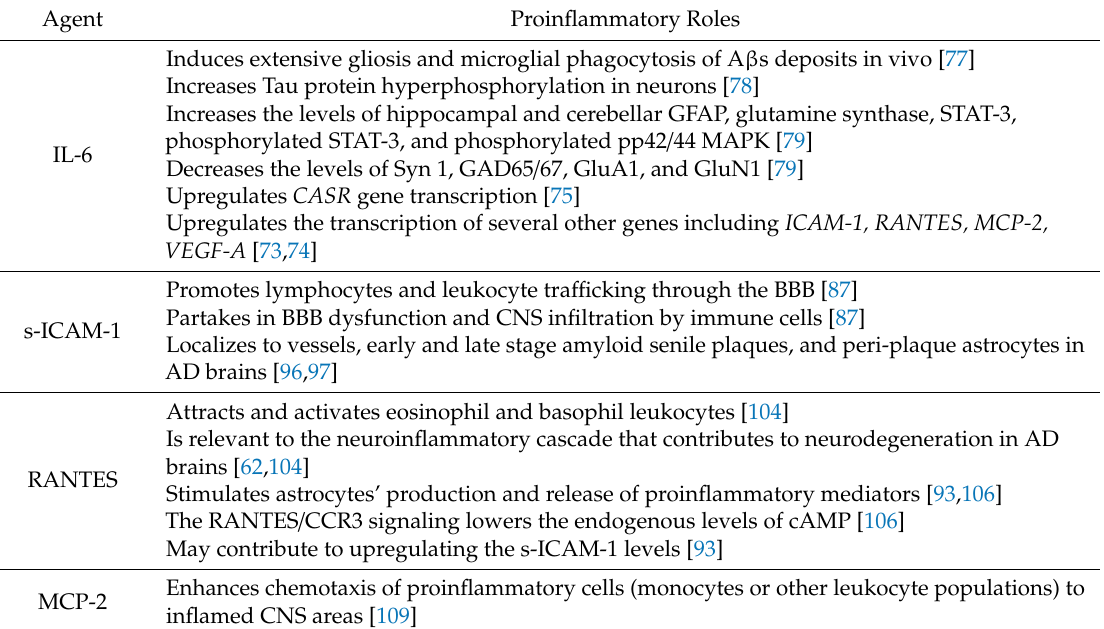
Table 3. IL-6, s-ICAM-1, RANTES, and MCP-2 drive complex neuroinflammatory responses.